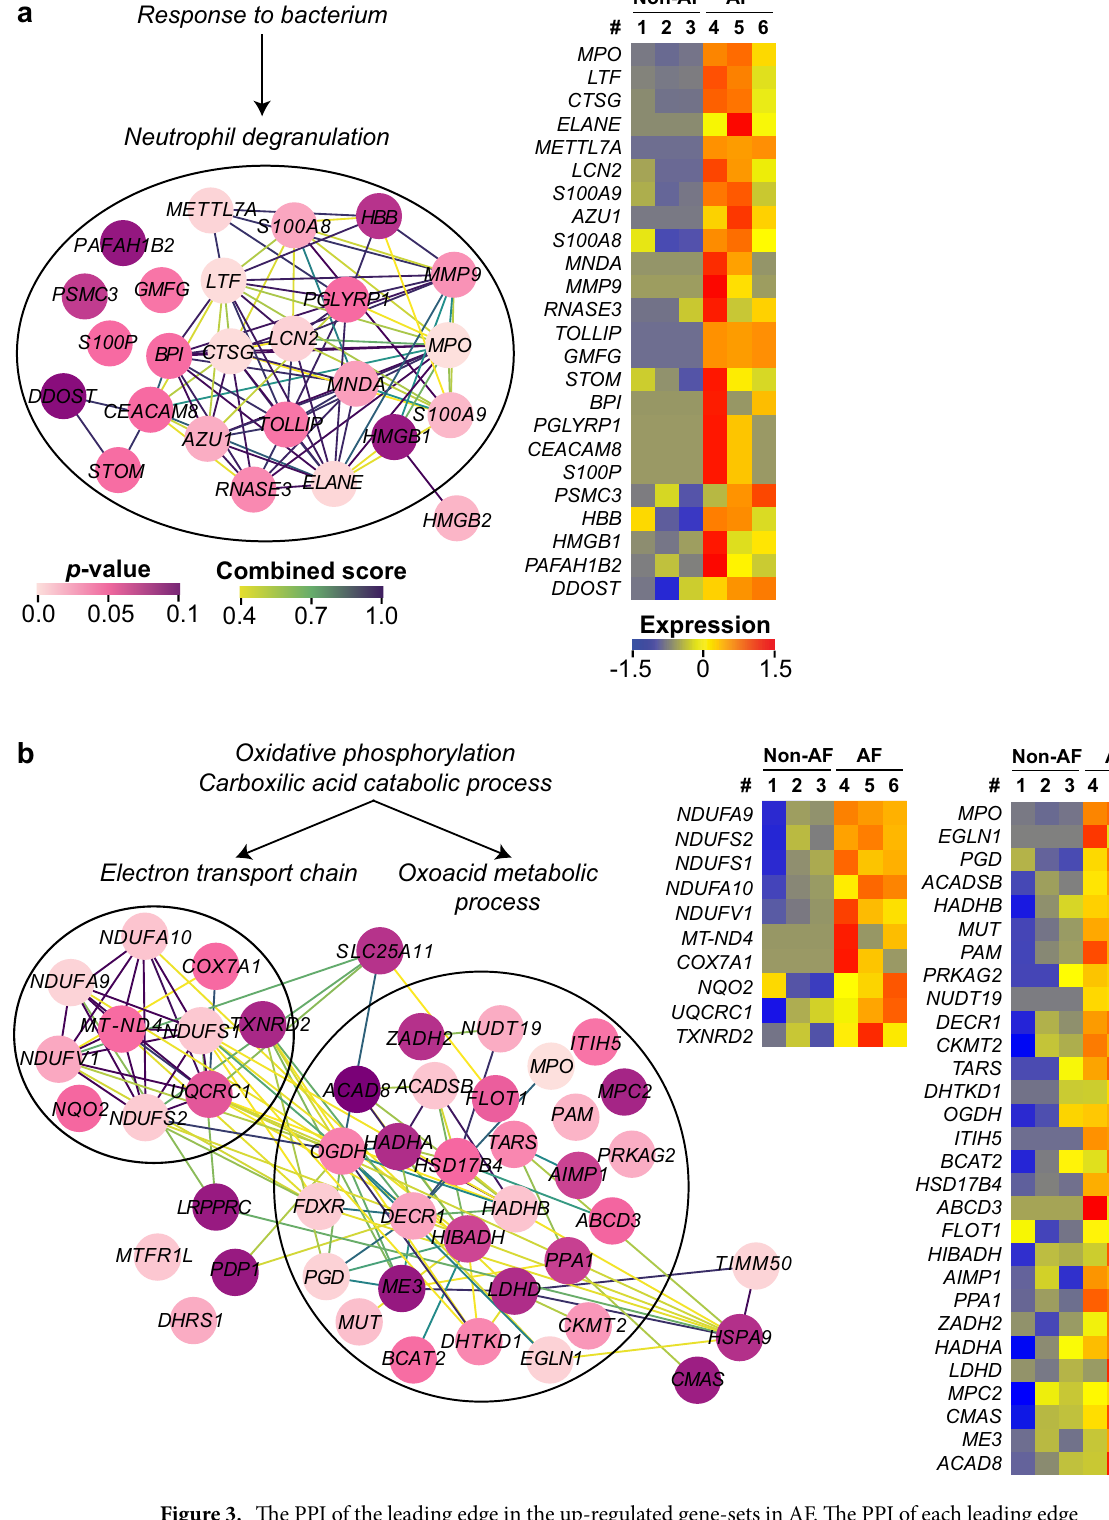
Figure 3. The PPI of the leading edge in the up-regulated gene-sets in AF. The PPI of each leading edge and their expression profile (heatmap) that were derived from ( a ) Response to bacterium , or ( b ) Oxidative phosphorylation and Carboxylic acid catabolic process . Among each gene-set, functionally grouped nodes (proteins) are encircled with its corresponding GO terms . Only the proteins with non-adjusted p -value < 0.1 are displayed here. The color of the nodes and the edges represent the non-adjusted p -value (0–0.1) and the STRING combined score (0.4–1.0), respectively. The color scale of expression represents the z-score of normalized spectral counts of each protein (shown as its gene name in each heatmap). The heatmaps were generated using R software 54 (version